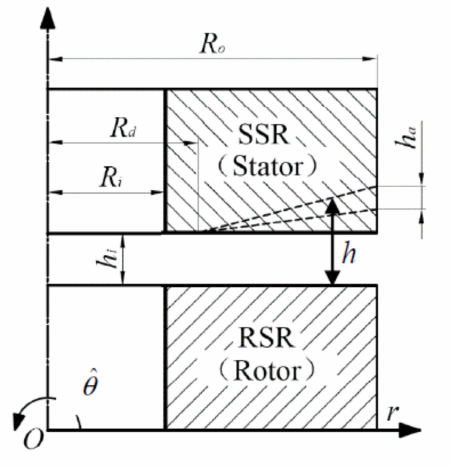
Figure 2. Model of the sealing